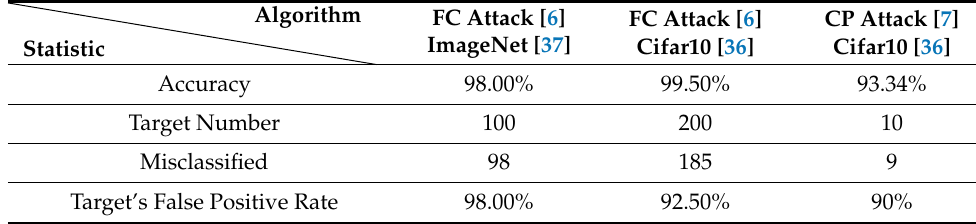
Table 4. Effects of FC and CP target attacks without Data Washing